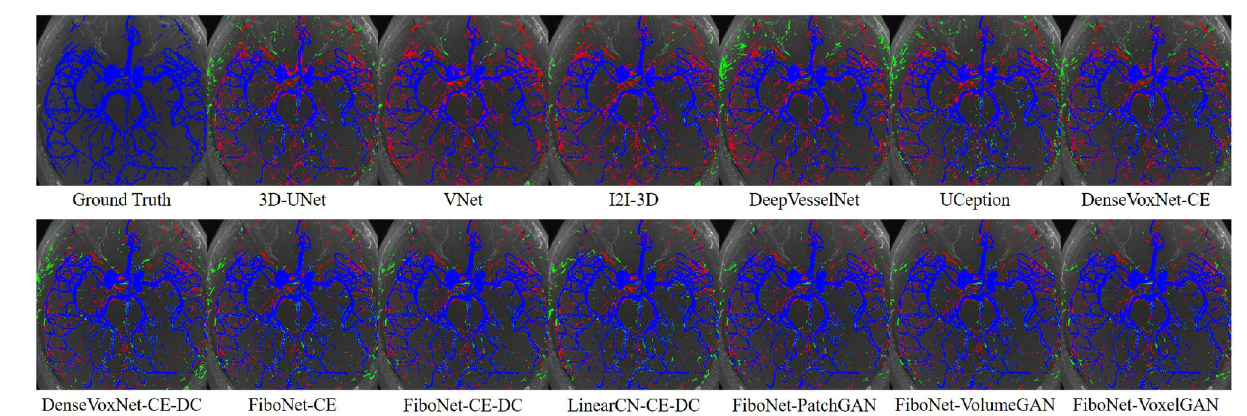
FIGURE 4 | Maximum intensity projections of each method. Pixels in blue represent true positives. Pixels in green represent false positives. Pixels in red represent false